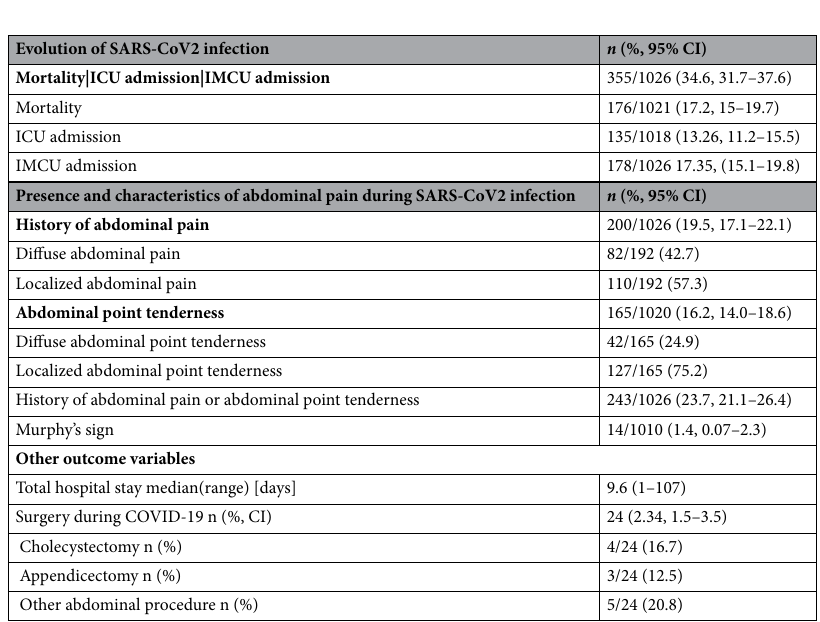
Table 2. Outcome variables. Primary outcome was defined by either ICU admission, MCU admission or death during the hospitalization (whatever the origin) Among 1026 patients, 200 had a history of abdominal pain whereas 165 out of 1020 (missing data for 6) reported pain induced by abdomen palpation. In 8 out of 200 patients with history of abdominal pain, localization was missing (192 patients with known localization). ICU: intensive care unit, IMCU: intermediate care